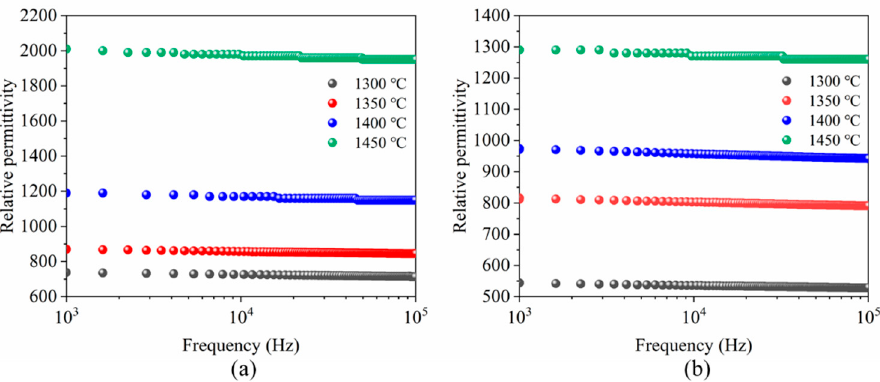
Figure 6. Relative permittivity of porous BCZT piezoelectric ceramics sintered at different tempera- tures ( a ) parallel to the freezing direction, ( b ) perpendicular to the freezing direction.